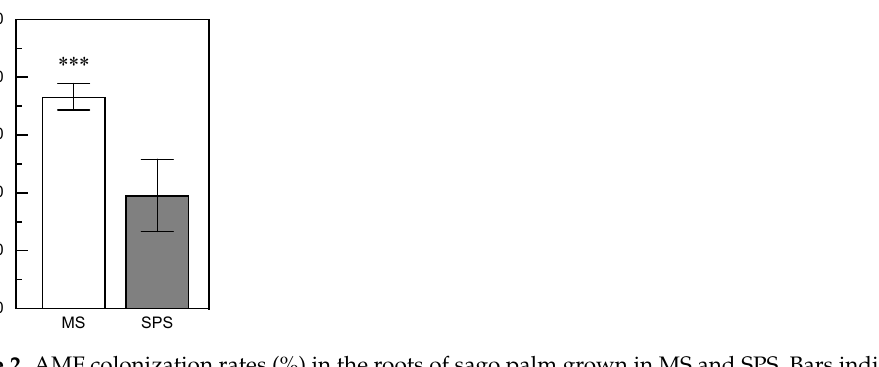
Figure 2. AMF colonization rates (%) in the roots of sago palm grown in MS and SPS. Bars indicate standard deviation of the means ( n = 5). *** indicate levels at the 0.001 probability level according to the Student t -test.